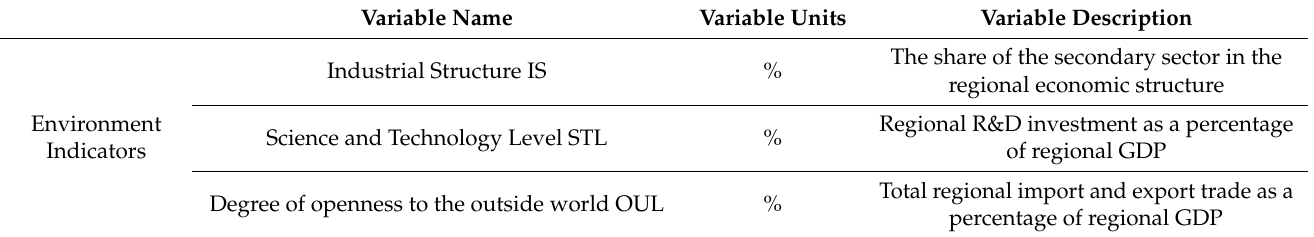
Table 3. Selection of environmental